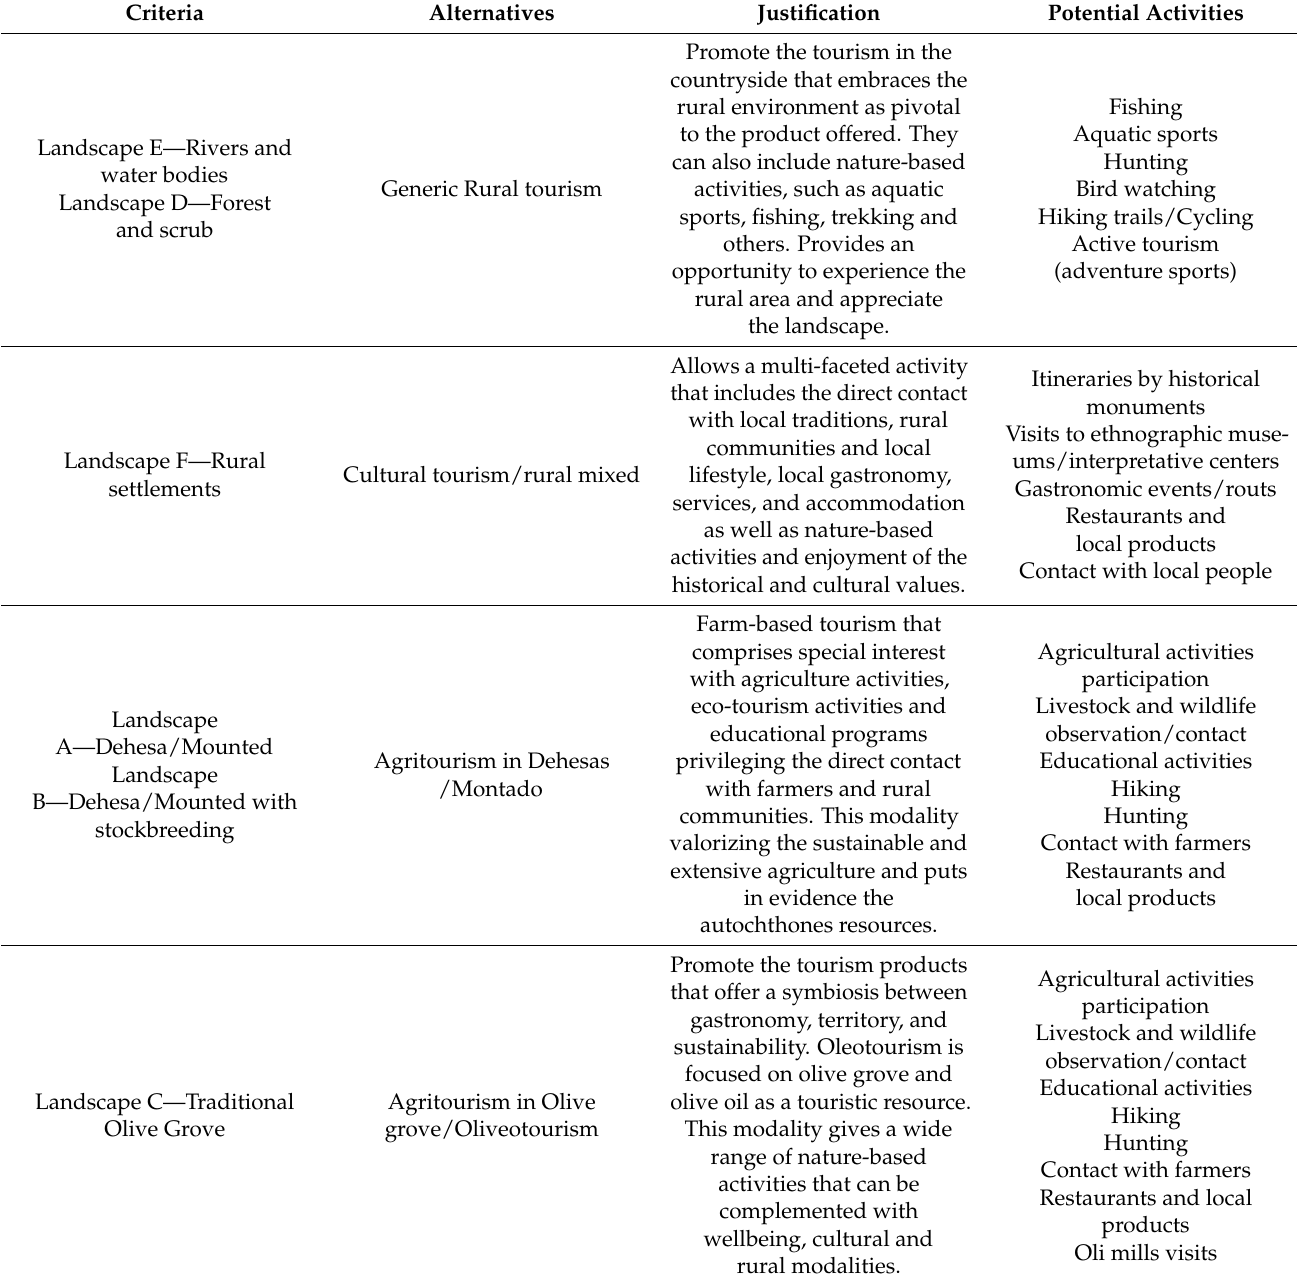
Table 3. Determination of alternatives based on landscape